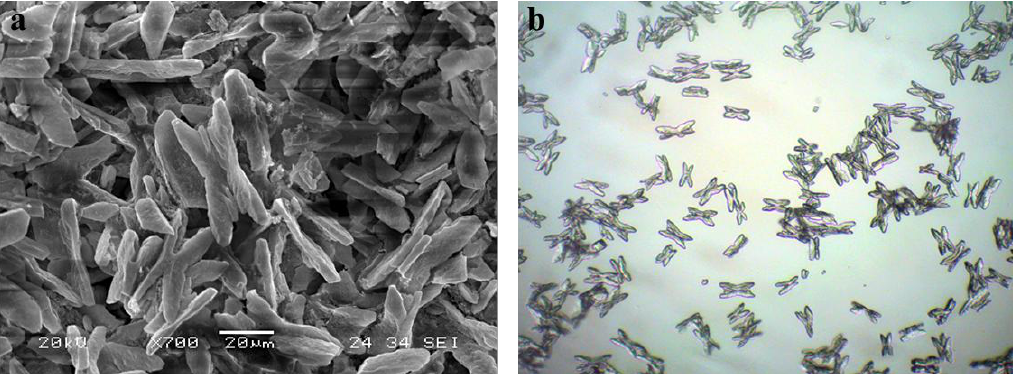
Figure 4. Microscopic pictures of struvite crystal morphology: scanning electron microscopy at pH 8.8 with magnification of ×700 (a), light microscopy at pH 8.8 with magnification of ×100 (b); The measure bars on (a) indicate 20 μm.